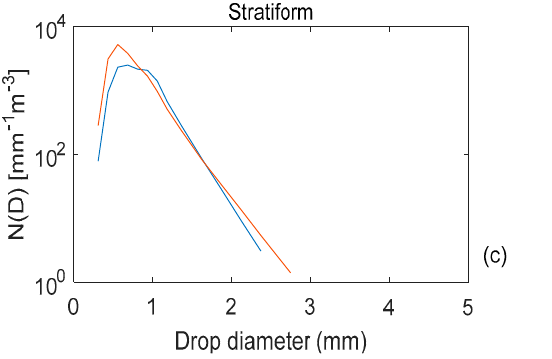
Figure 2. Raindrop size distribution in Kolkata and Bologna for ( a ) the whole dataset, ( b ) convective rain and ( c ) stratiform rain.